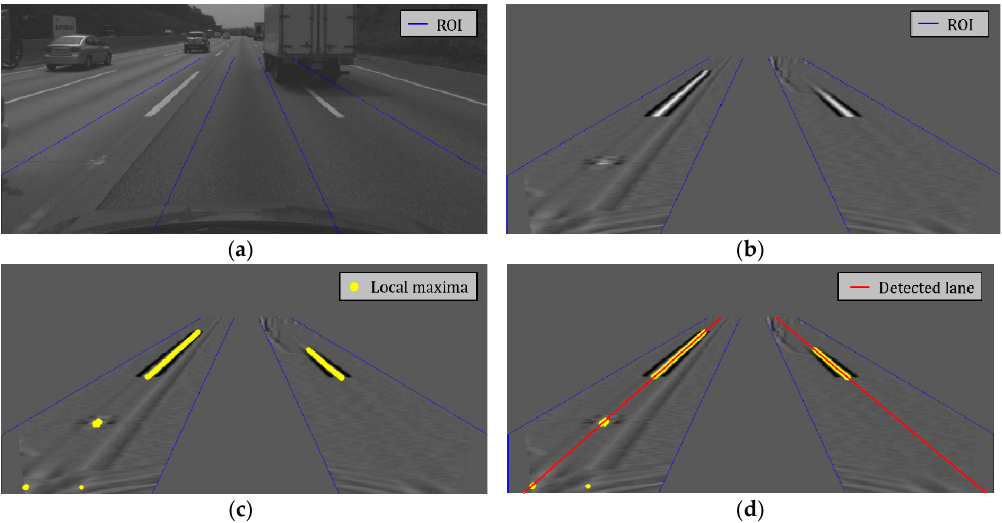
Figure 4. Procedures for lane detection. ( a ) Regions of interest for lane detection; ( b ) Top-hat filtering result; ( c ) Local maxima locations; ( d ) Lane detection result. result; ( c ) Local maxima locations; ( d ) Lane detection